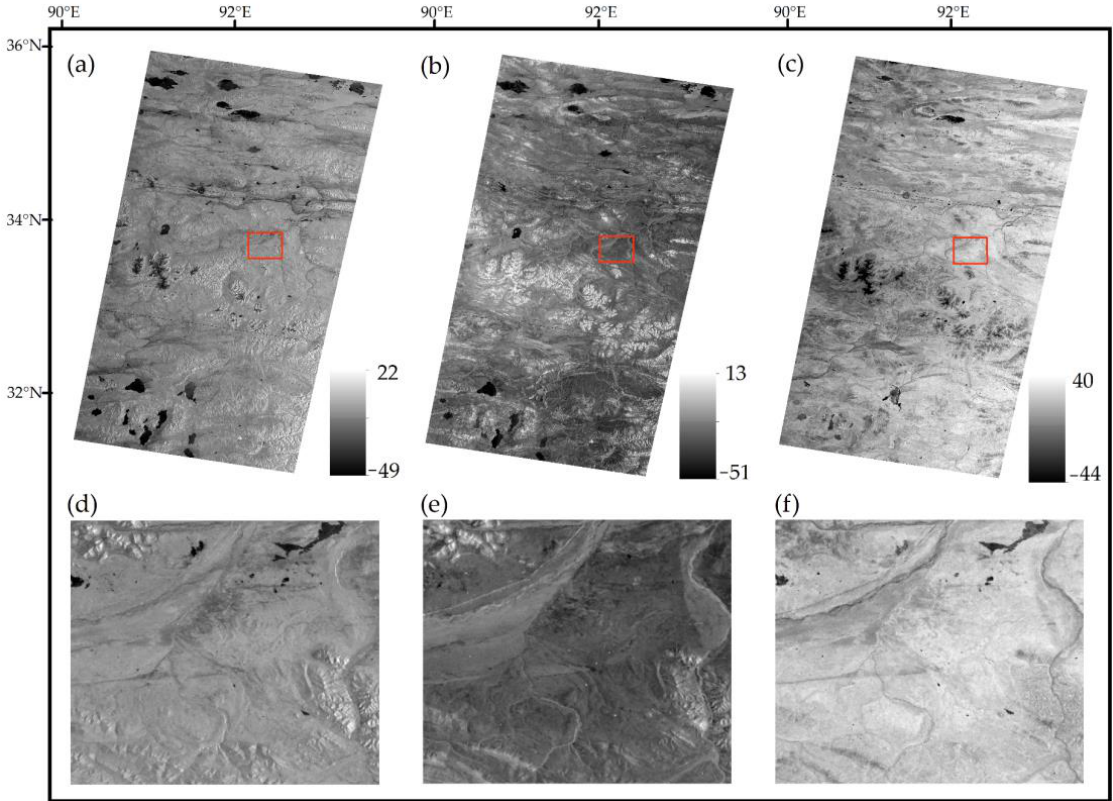
Figure 4. The distribution of σ s , σ w , and Δ σ and details in the study area. ( a ): The σ ° on 2 July 2018. ( b ): The σ w in 2018. ( c ) : The Δ σ. ( d – f ): The details after scaling up of σ ° , σ w , and Δ σ within the red box .